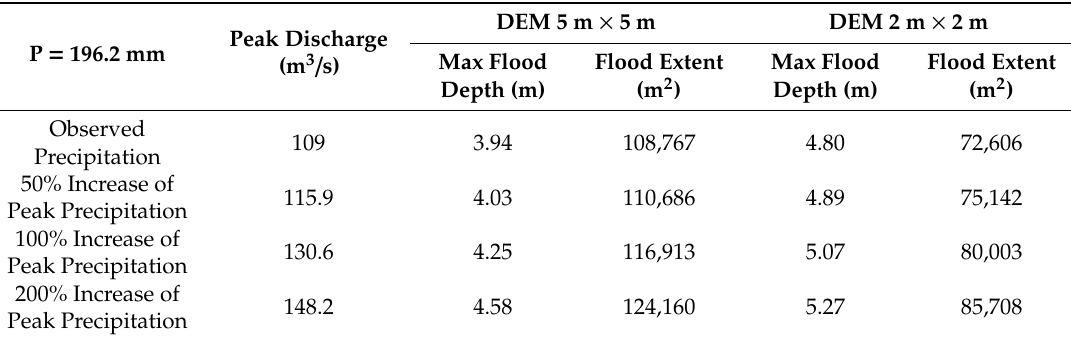
Table 4. Maximum flood depth (m) and flood extent (m 2 ) resulting from the observed precipitation and increase in peak precipitation by factors of 1.5, 2.0, and 3.0, by using the coupled 1D / 2D HEC-RAS model, at high-resolution DEMs (5 and 2